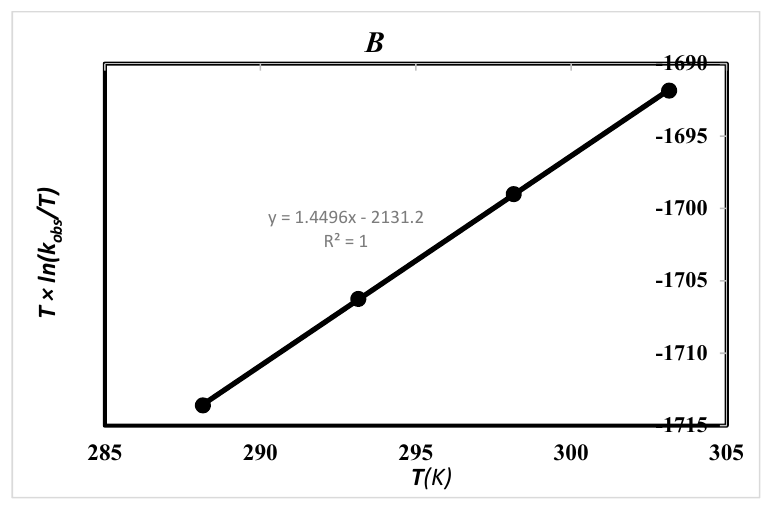
Figure 7. Eyring plots, for the reaction between TPP, DMAD and MA in ethanol at a wavelength of 320 nm: ( A ) according to Equation (8); ( B ) according to Equation (9).